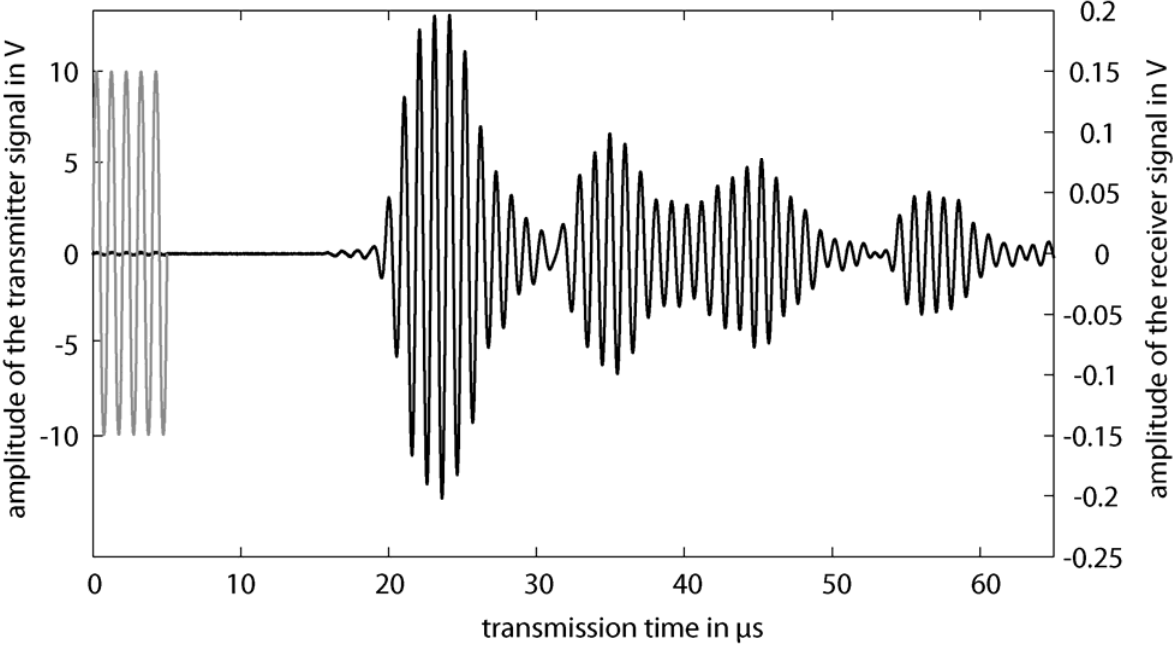
cycles ( grey ). The receiver signal consists of several distinguished wave groups ( black